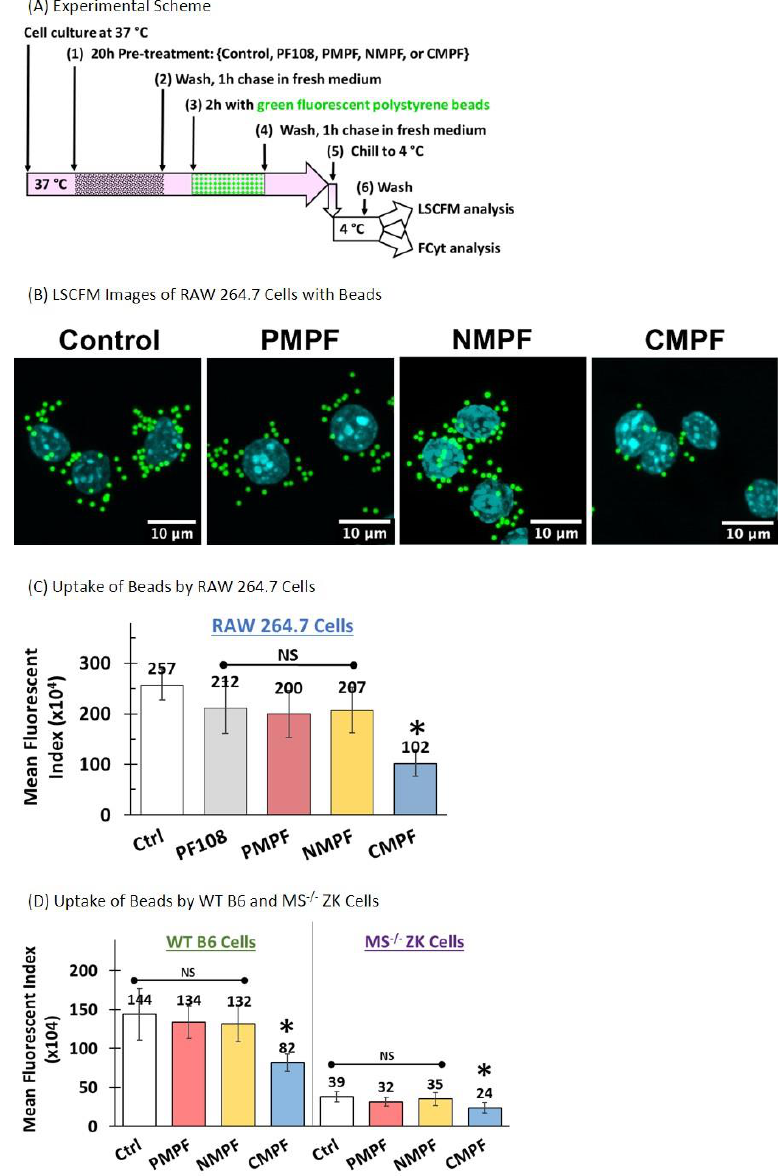
Figure 6. Effects of MWNT accumulation on subsequent phagocytosis of polystyrene beads in murine alveolar macrophage cell lines. RAW 264.7, wild type B6, and MS −/− ZK cells were incubated in media containing 100 µg/mL of P-, N-, or C-MWNTs at 37 °C for 20 h. Untreated control cells were incubated in regular culture medium in the absence of PF108 surfactant or MWNTs. Cells were prepared for LSCFM or FCyt as described in Methods. ( A ) The timeline scheme outlines the key experimental steps. ( B ) Representative LSCFM images of untreated control and MWNT-treated cells. Blue fluorescence is emitted from Hoechst 33342 stained nuclei and green fluorescence is from phagocytosed polystyrene beads. ( C ) Mean fluorescence index of RAW 264.7 control, cells pre-treated with 0.1 mM PF108 alone, or with 100 µg/mL of P-, N-, or C-MWNTs. ( D ) Mean fluorescence index of WT B6 (left panel) and MS −/− ZK (right panel) controls and cells pre-treated with 100 µg/mL of P-, N-, or C-MWNTs. Data are the mean ± SD of duplicate measurements per sample in ≥ 3 independent experiments. NS is for